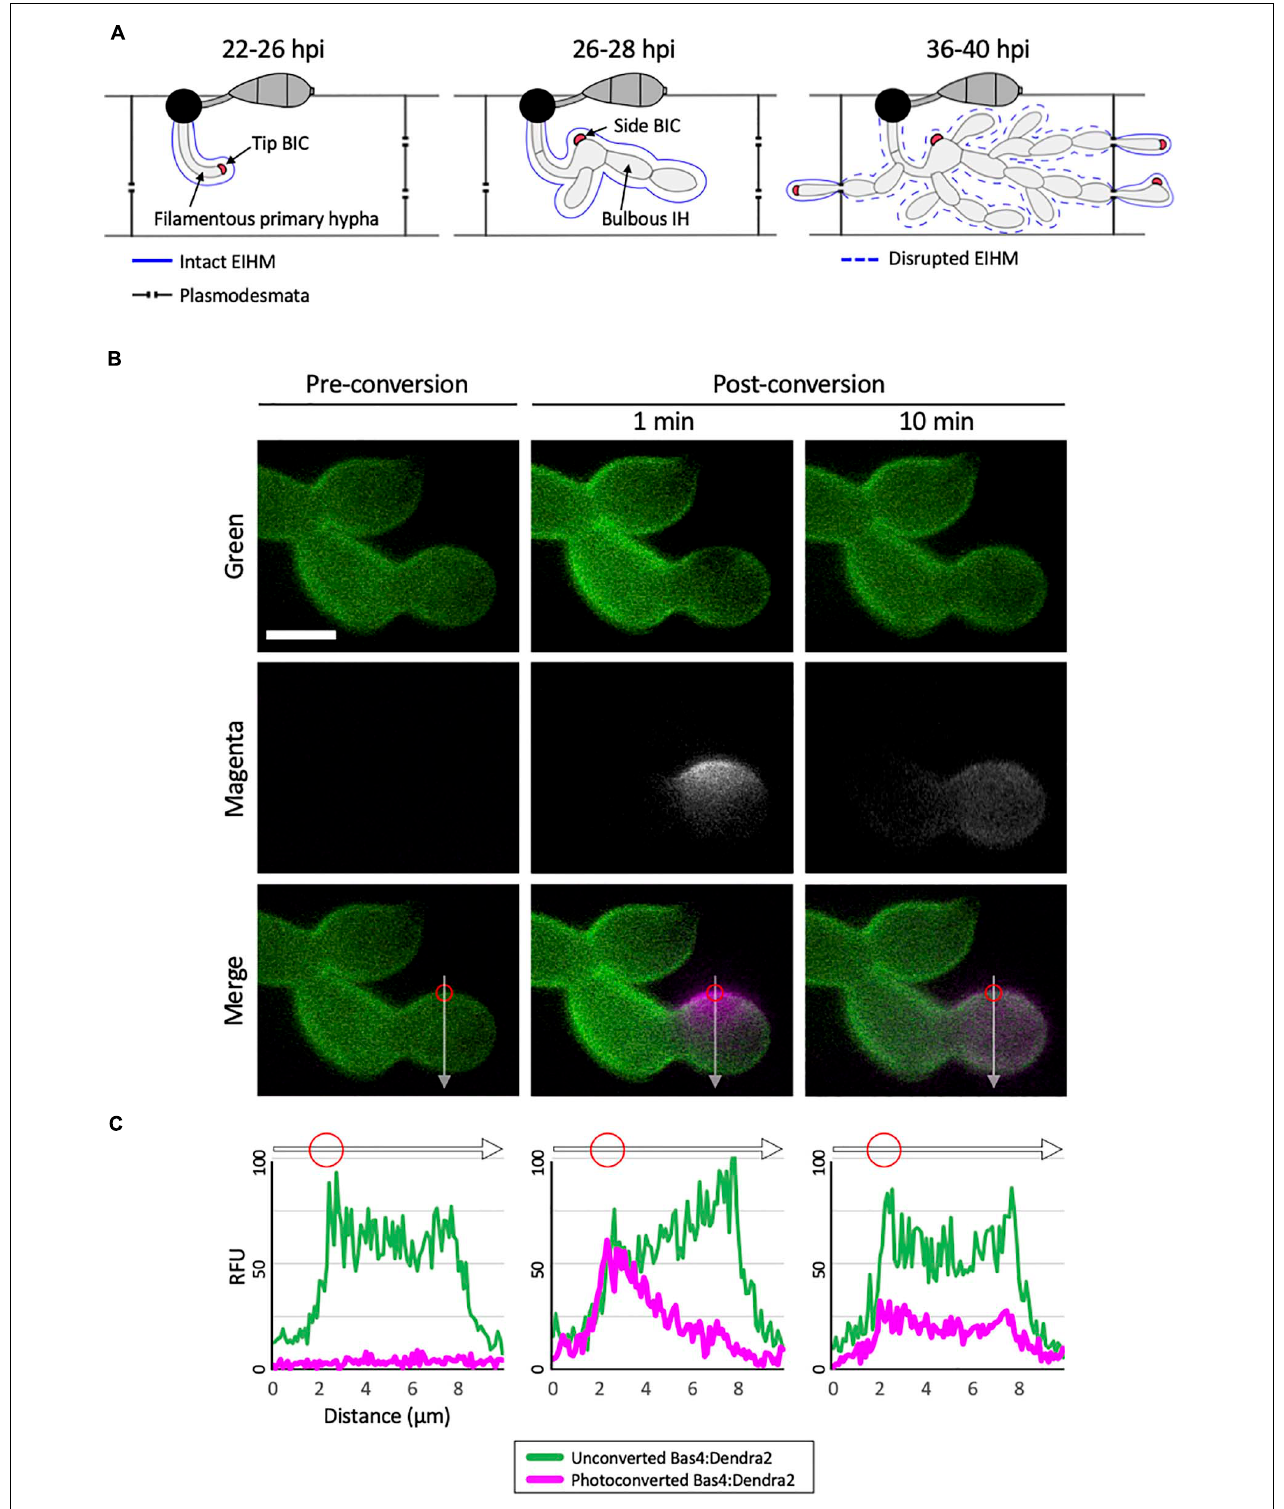
FIGURE 1 | Bas4 is freely diffusible inside the EIHMx. (A) Schematic diagram summarizing the invasion of first and second rice cells by M. oryzae invasive hyphae (IH). At 22–26 h post inoculation (hpi), a filamentous primary hypha grows in the first-invaded host cell, where it is surrounded by an intact EIHM. Apoplastic effectors secreted by IH are retained within the EIHMx. In contrast, cytoplasmic effectors enter the host cytoplasm and show preferential accumulation at the tip BIC located at the apex of the primary hypha. At 26–28 hpi, the filamentous primary hypha switches to depolarized, asymmetric growth, leaving the BIC subapically